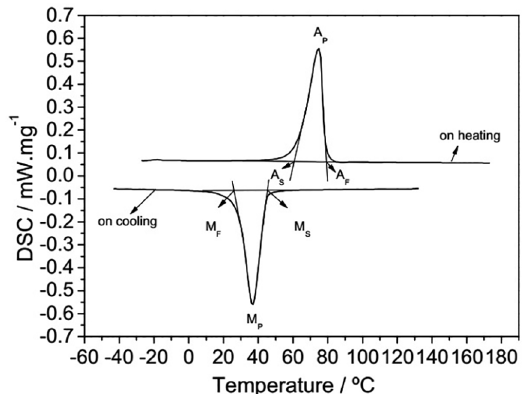
Figure 2. DSC measurements of transformation behavior of the solution treated 2.080 mm in diameter wire. (DTM). At 70 °C, the wire has a mixed crystallographic state (M + A), where the temperature is between A